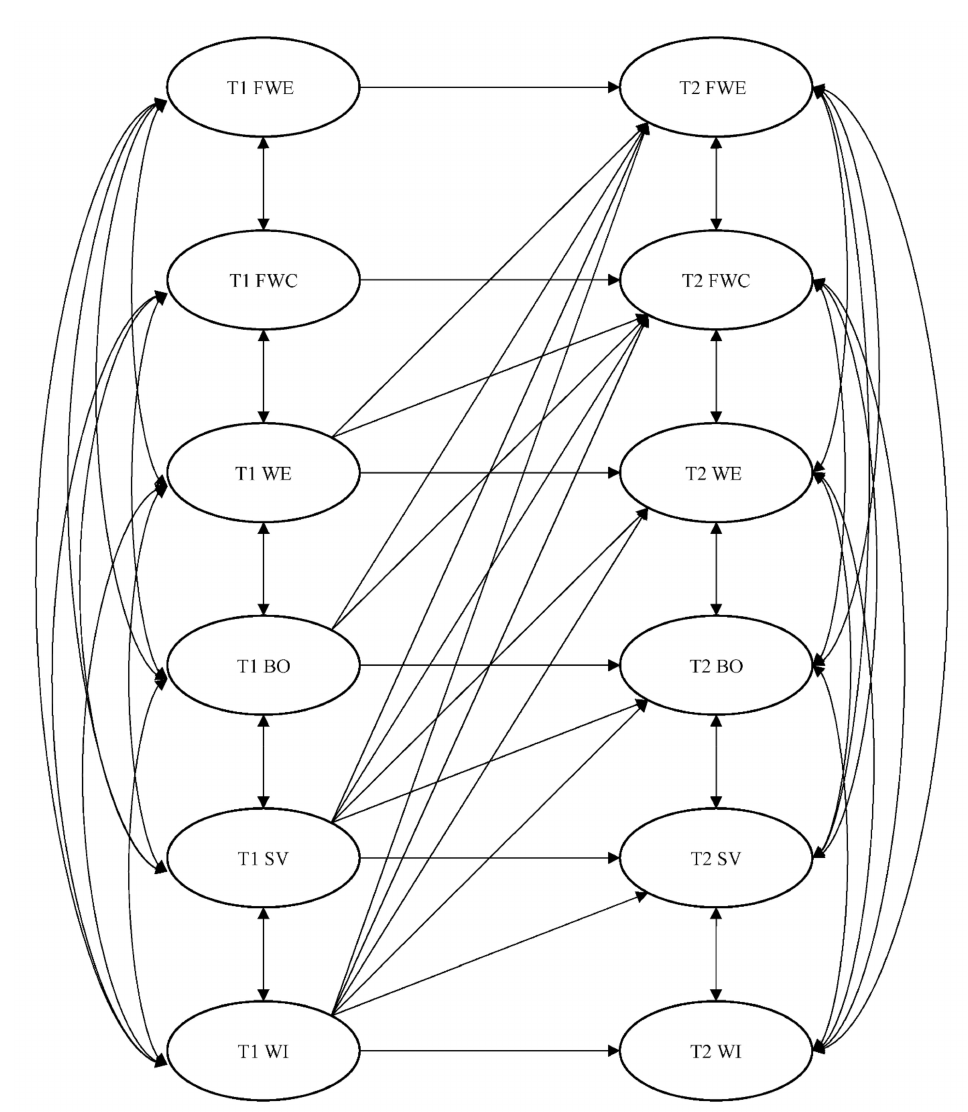
Figure 3. The alternative reversed causation model. FWE = family-to-work enrichment; FWC = family-to-work conflict; WE = work engagement; BO = burnout; SV = safety violations; WI = workplace